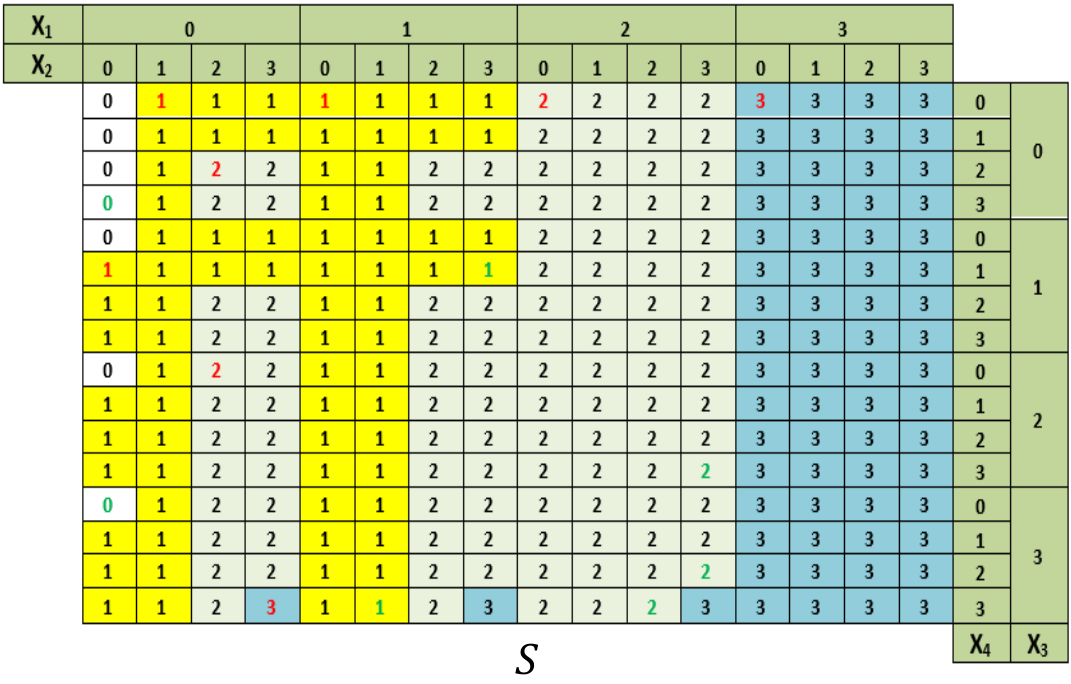
Figure 1. A multi-valued Karnaugh map (MVKM) for the structure function of a multi-state coherent threshold system. Map entries are superfluous, since it suffices to state the minimal upper vectors (cells with entries colored in red) or the maximal lower vectors (cells with entries colored in